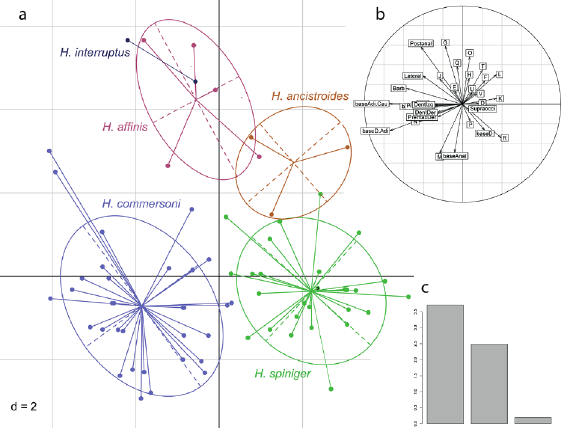
Figure 4 - Between-class Analysis (BCA) of morphological data of H. commersoni , H. spiniger , H. affinis , H. punctatus and H. ancistroides . a . Projection of individuals’s scores onto first factorial plane of BCA, axis 1 horizontal and axis 2 vertical; b , Correlation of the variables labelled as in Tables I and II; c ,